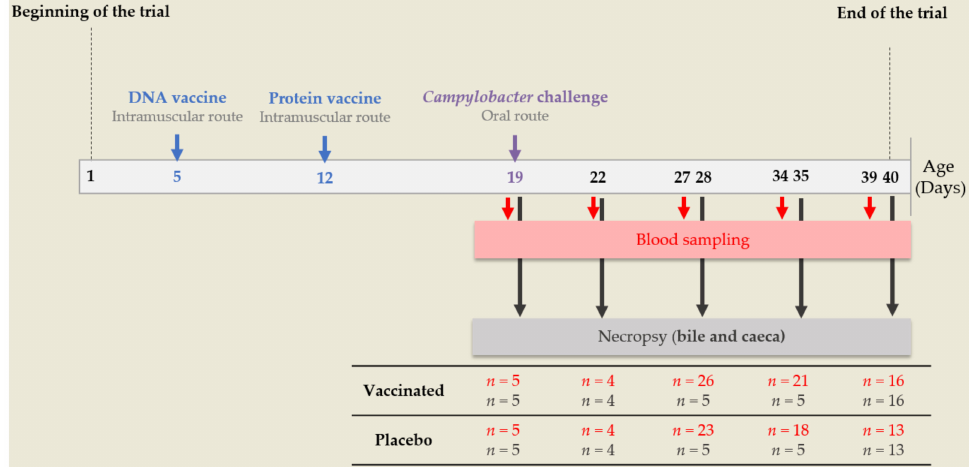
Figure 1. Main steps of the experimental procedure. Each day, the number of chickens ( n ) used for blood sampling and necropsy is represented in red or brown